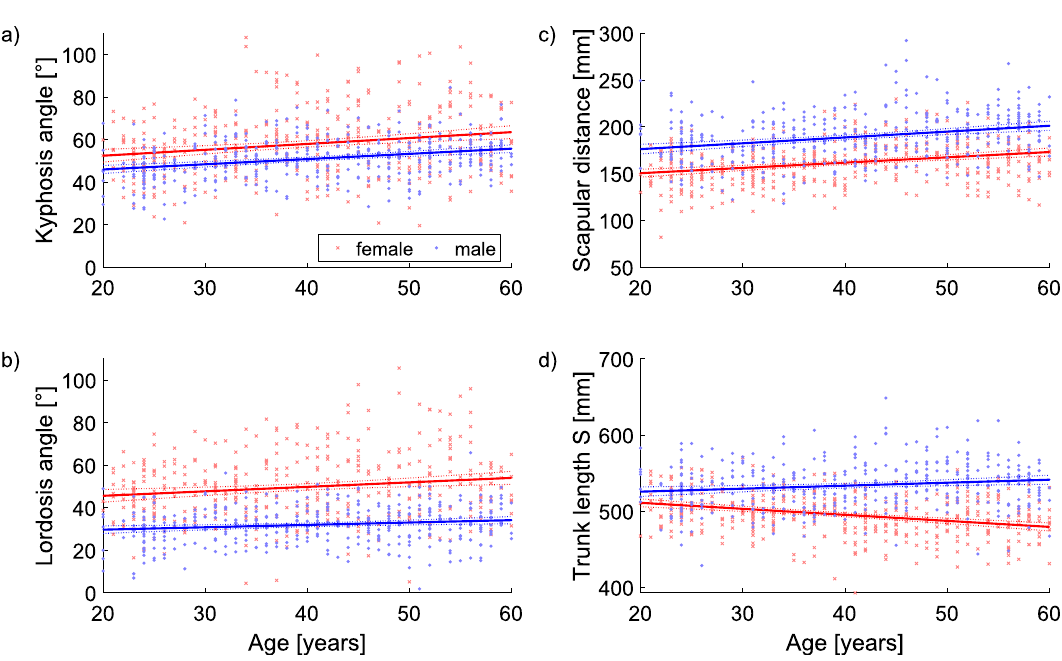
Figure 2. Age-dependent differences for the kyphosis and lordosis angles, and for the scapular distance and trunk